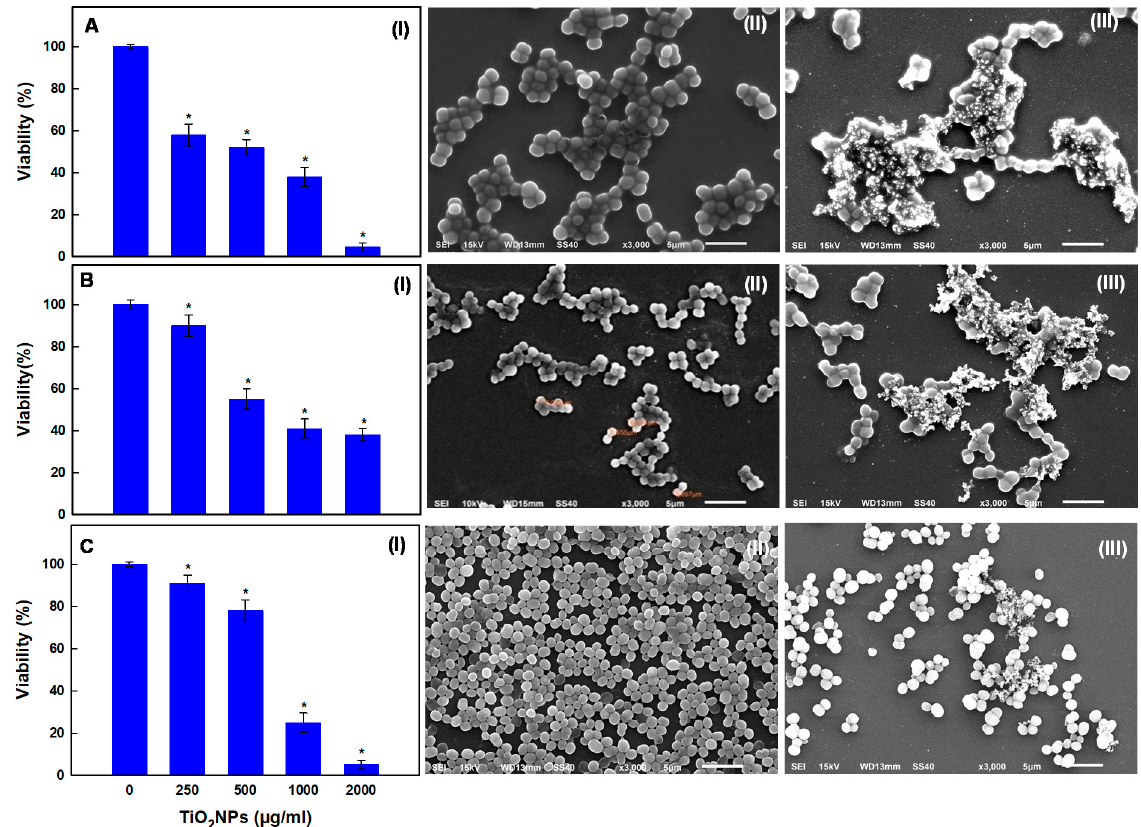
Figure 5. Reductions in the percentage viability of Gram positive SJM-04 ( AI ), SJM-38 ( BI ), and SJM-65 ( CI ) treated with 250, 500, 1000, or 2000µg/mL concentrations of TiO 2 NPs for 24h. SEM micrographs showing morphological changes in SJM-04 ( AIII ), SJM-38 ( BIII ), and SJM-65 ( CIII ) cells after treatment with TiO 2 NPs at 250µg/mL vs. untreated control cells ( AII – CII ). ‘*’ denotes the statistical difference at p ≤ 0.05 between control and treated groups.